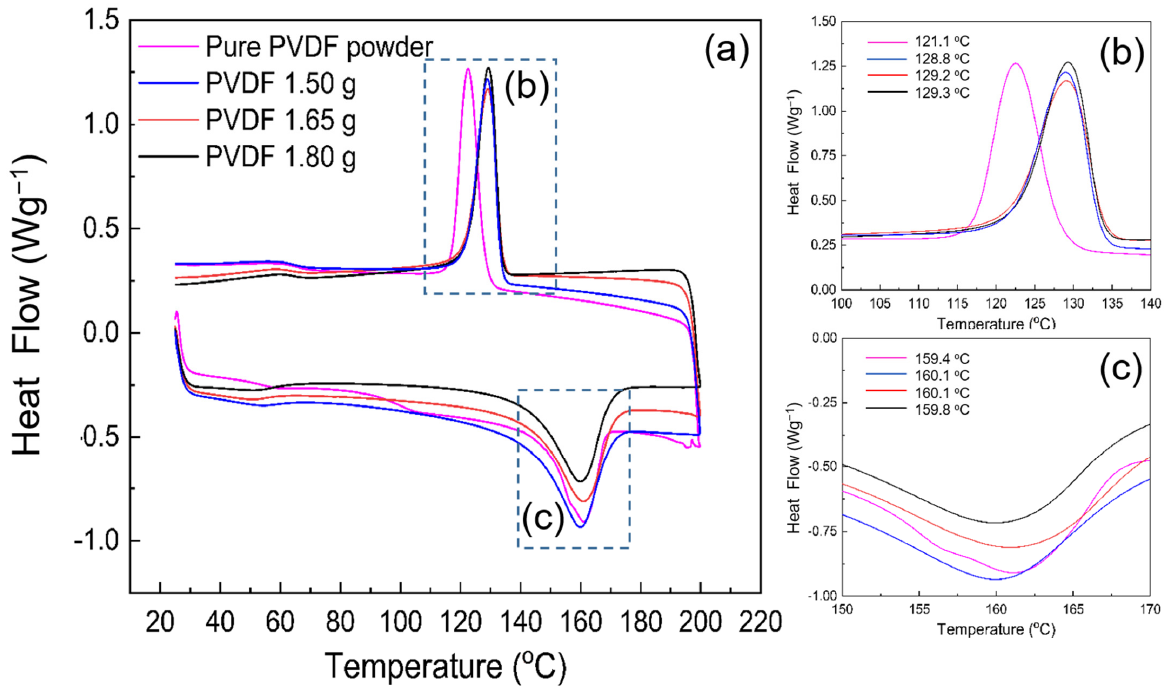
Figure 7. ( a ) DSC trace of the pure PVDF powder and electrospun PVDF nanofibers including samples A, B and C; ( b ) cooling thermograms and ( c ) heating thermograms of fibrous and powdery samples.